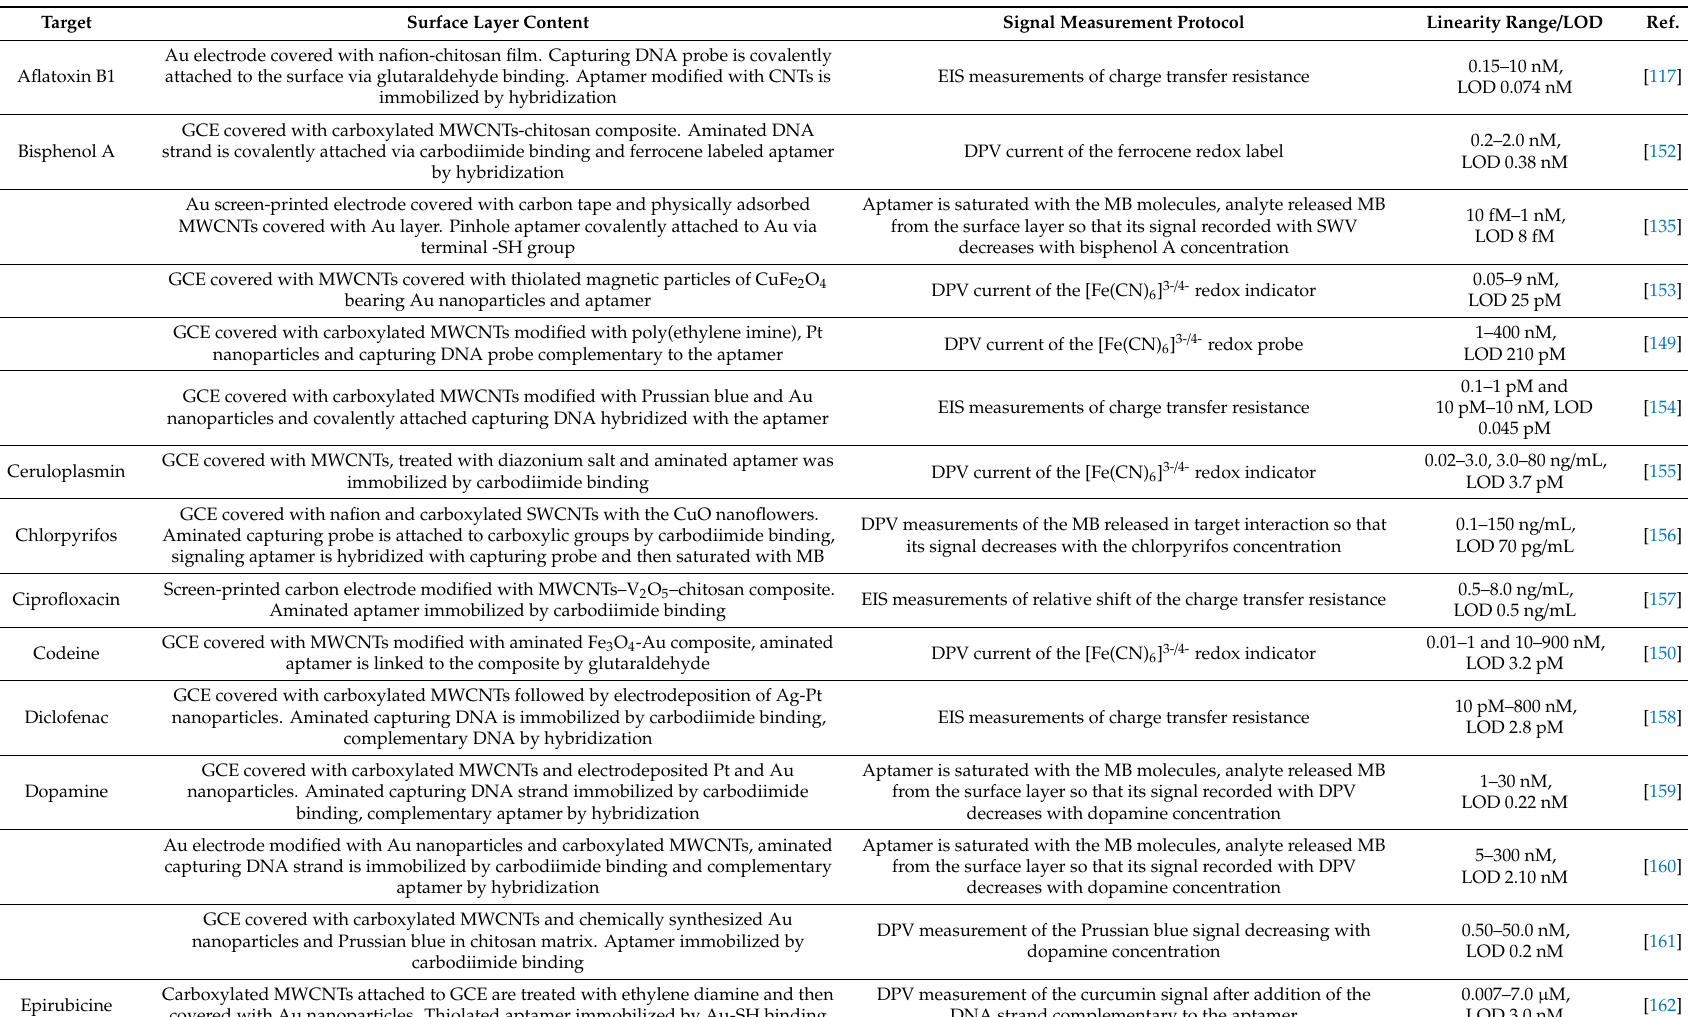
Table 1. Characteristics of electrochemical aptasensors based on CNTs